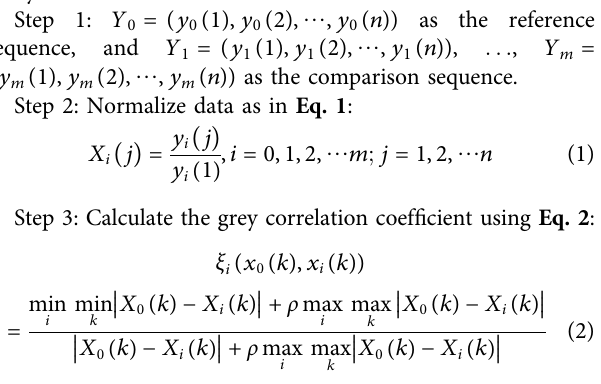
analysis of the air pollution data of Beijing and Zhangjiakou, and the socio – economic indicators of the two regions. Grey relational analysis is used to determine the degree of relation between different data by the proximity of reference data and comparison data, and the speci fi c steps of grey relational analysis are as follows.